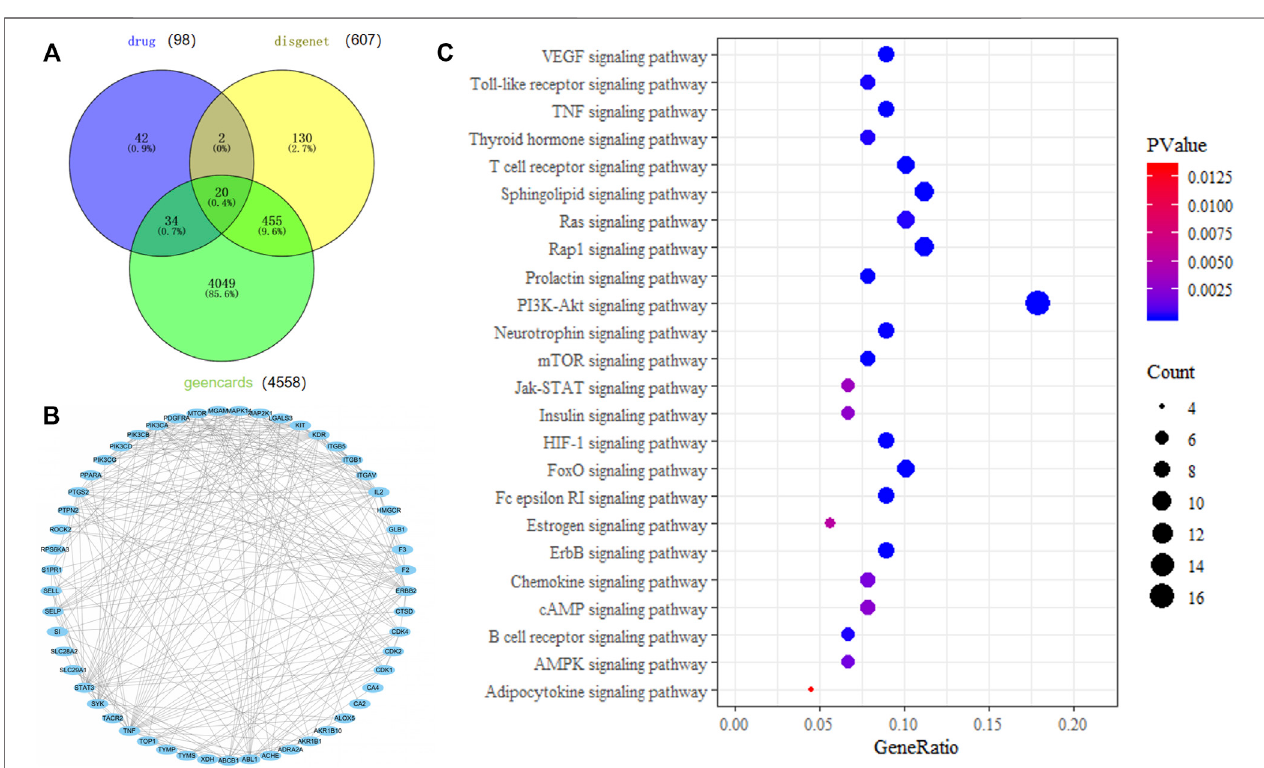
FIGURE1 | Network pharmacology analysisofthe mechanism ofaction ofICA inthe treatment ofcolitis. (A) Venn diagram ofintersectionof ICA targets and colitis targets. (B) ICA target protein interaction network. (C) KEGG pathway analysis of ICA target.